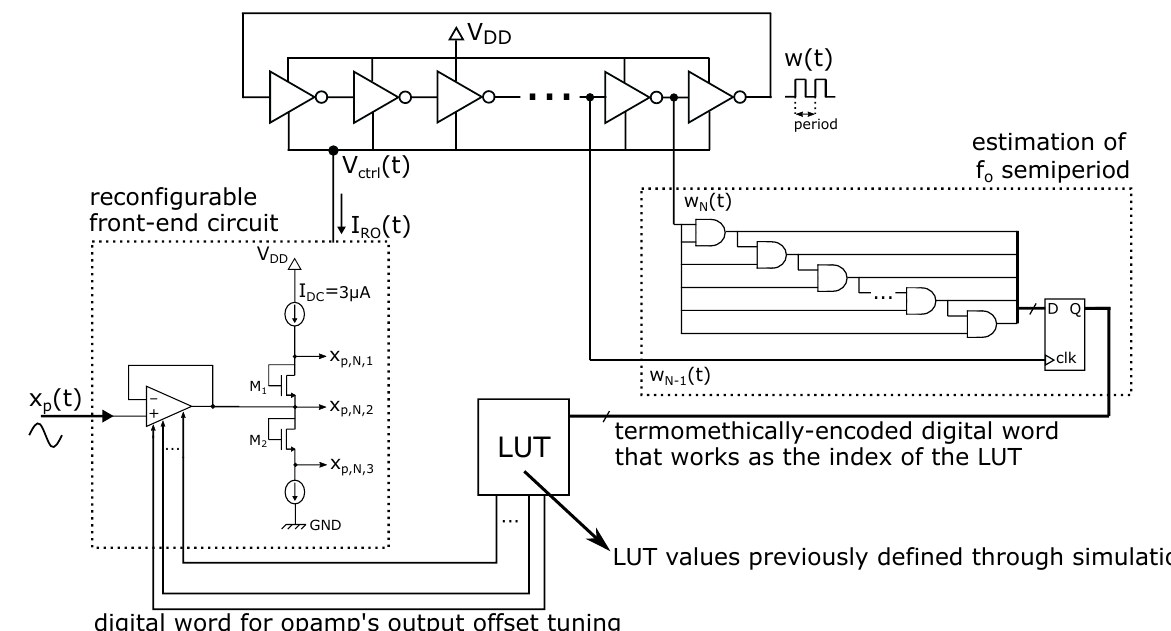
Figure 11. Scheme of the proposed calibration